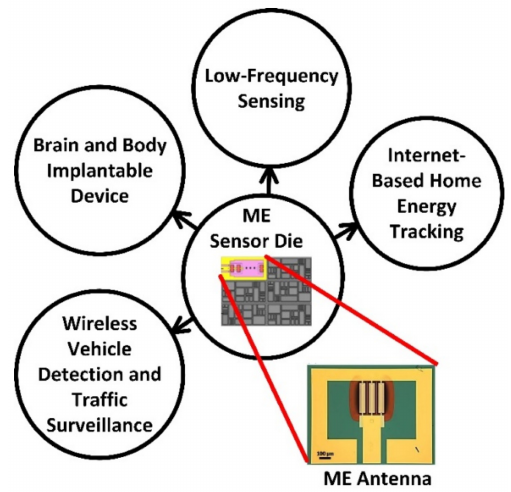
Figure 1. Potential magnetoelectric (ME) sensor